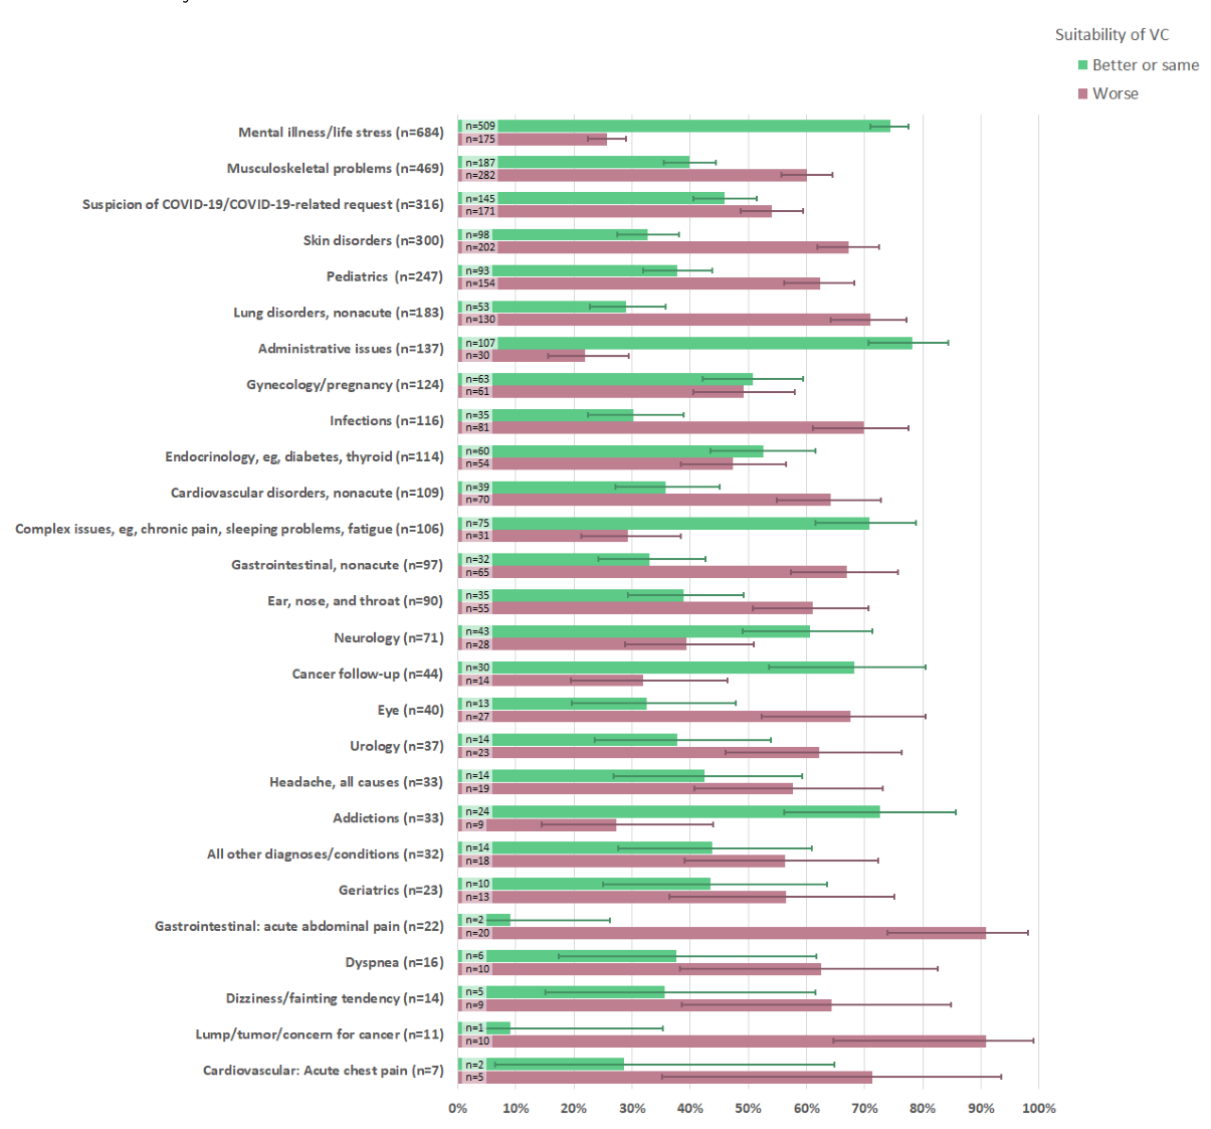
Figure 3. General practitioners' perceived suitability of video consultations compared to an envisaged face-to-face consultation for the same issue, according to the nature of the main problem/reason for contact. The contact reasons are presented in decreasing frequency (n) from top to bottom, and 95% CIs are illustrated by lines. VC: video